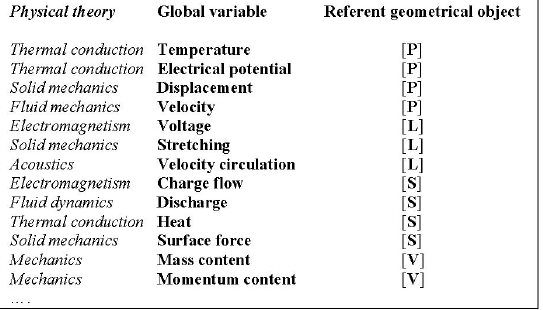
Figure 4: Association between physical variables and points ( P ), lines ( L ), surfaces ( S ), and volumes ( V ) for several physical